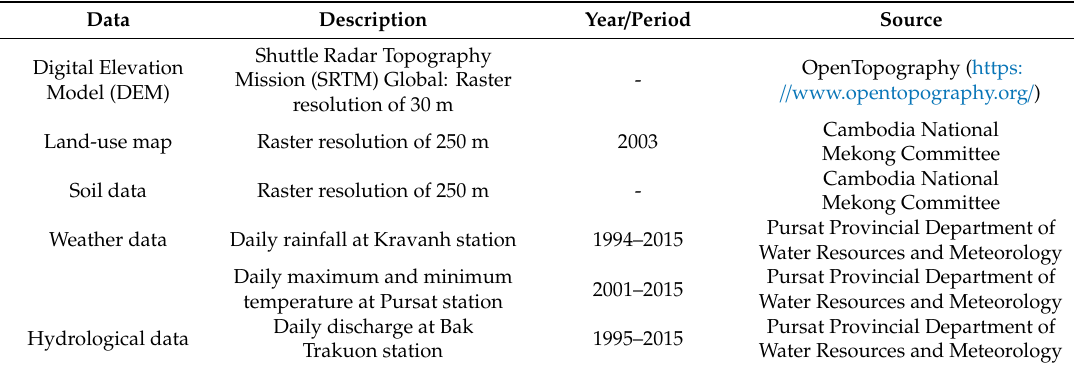
Table 1. Description of data used in this